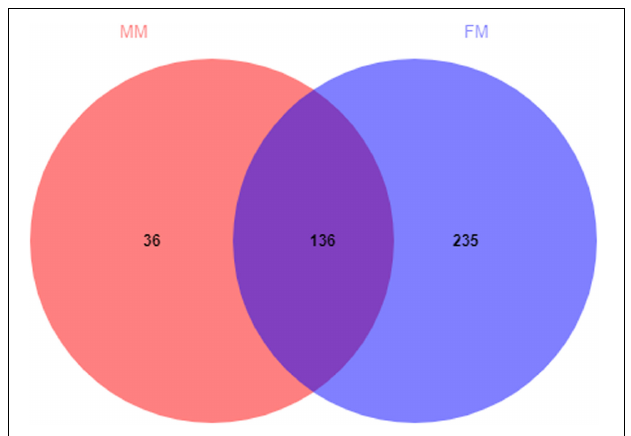
FIGURE 1 | Venn diagram of OTUs in the female and the male swamp eels. The numbers of shared and unique OTUs are